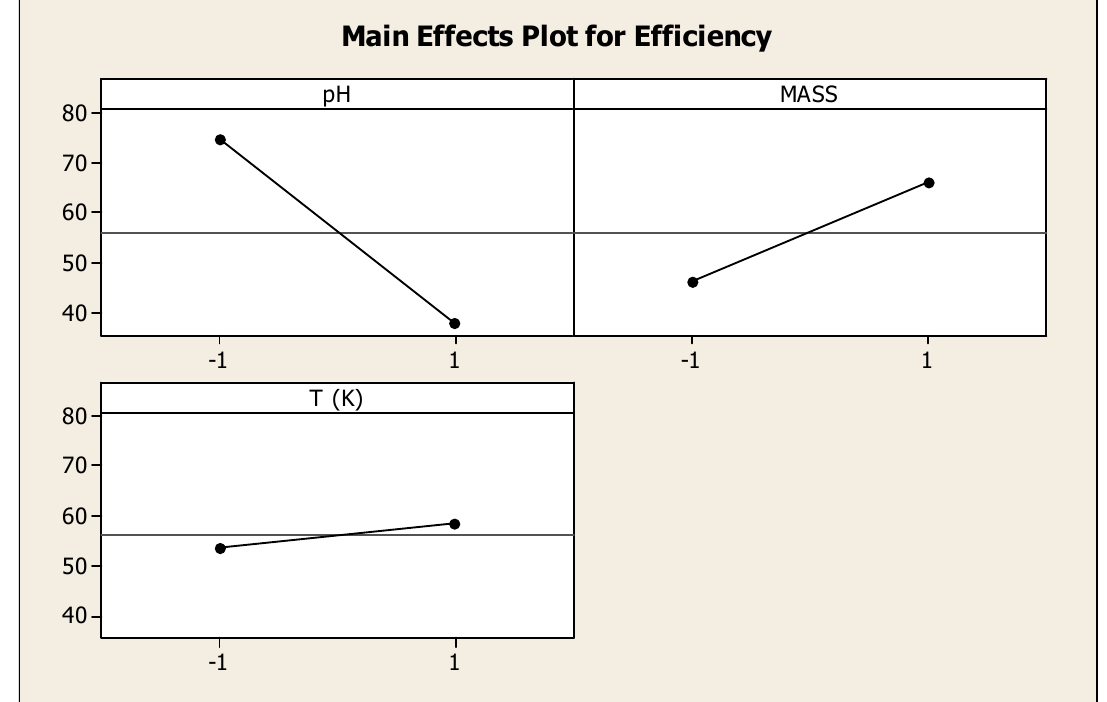
Figure 9. Effect of the investigated factors on BR dye removal efficiency.